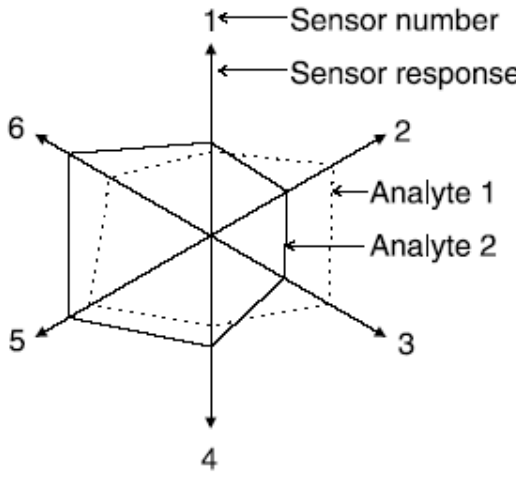
Figure 6. A polar plot of sensor response